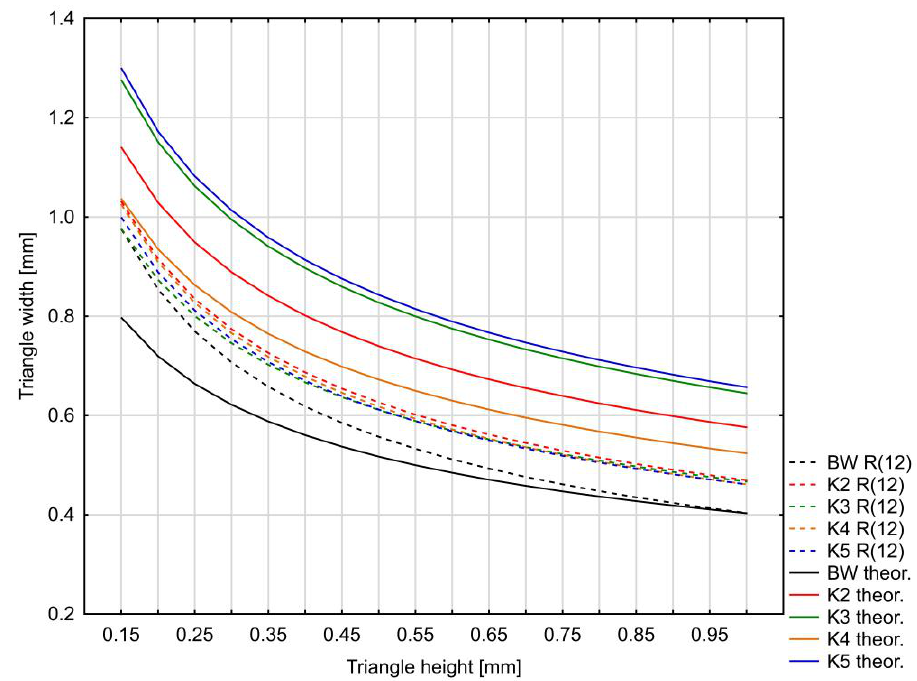
Figure 12. Comparison of performed regression models in all variants (BW and K2–K5, dashed line) with theoretical curves.